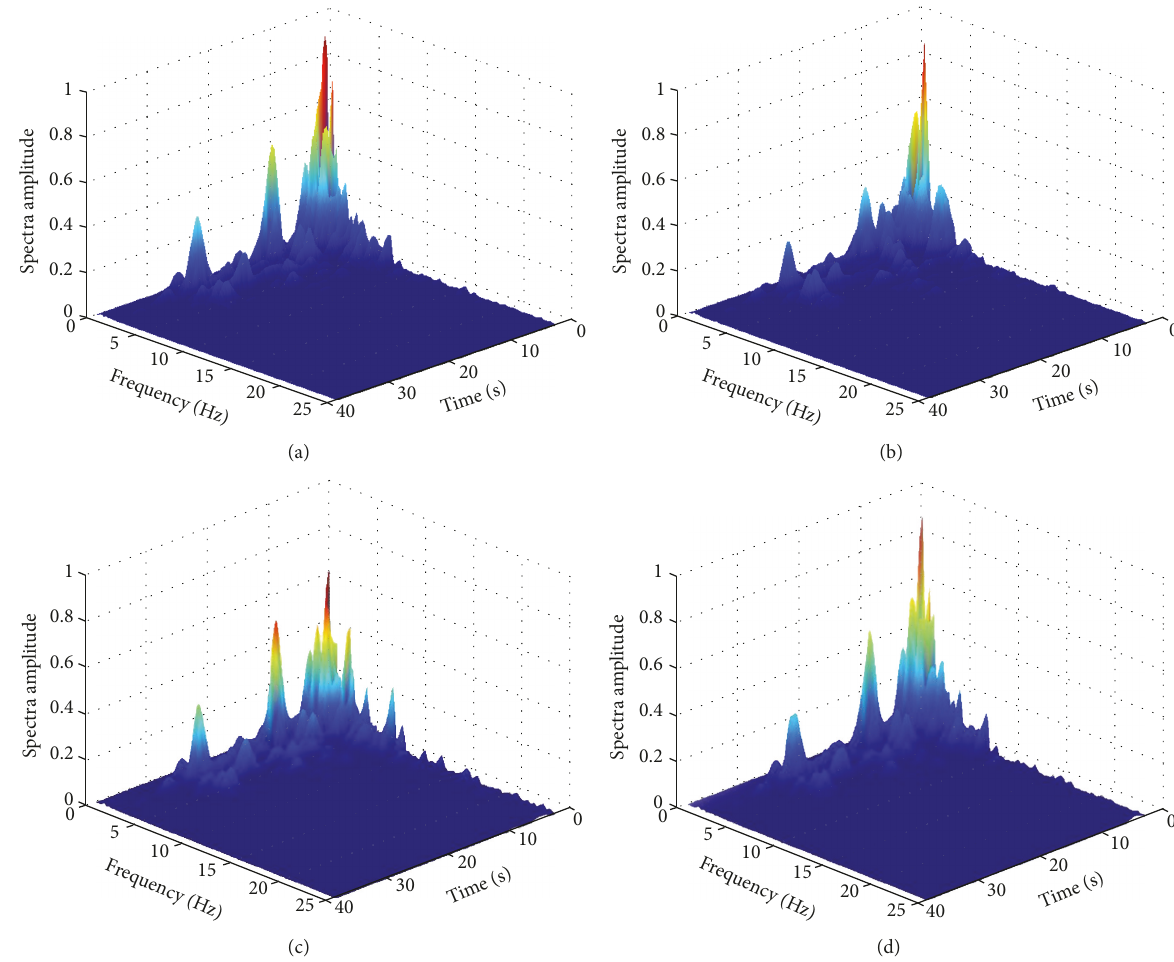
Figure 7: Comparison of time-frequency spectral at simulated stations to that of the original record: (a) the time-frequency spectrum of the known record; (b), (c), (d) the time-frequency spectrum of 1–3 simulated